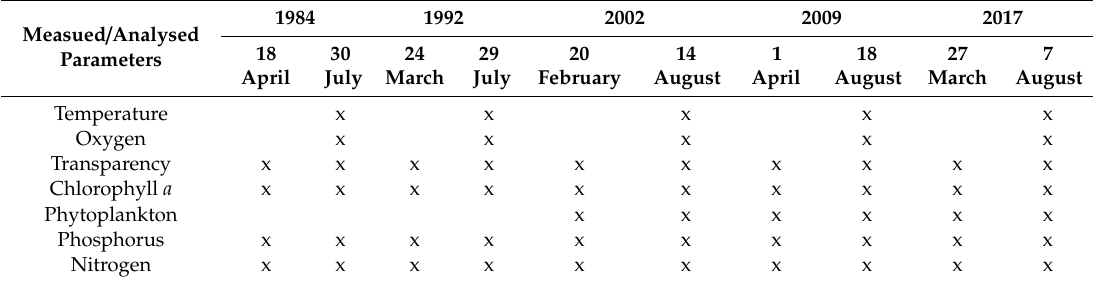
Table 1. Dates of the measurements and sampling conducted by Voivodeship Inspectorate of Environmental Protection in Bydgoszcz VIEP and presented in this